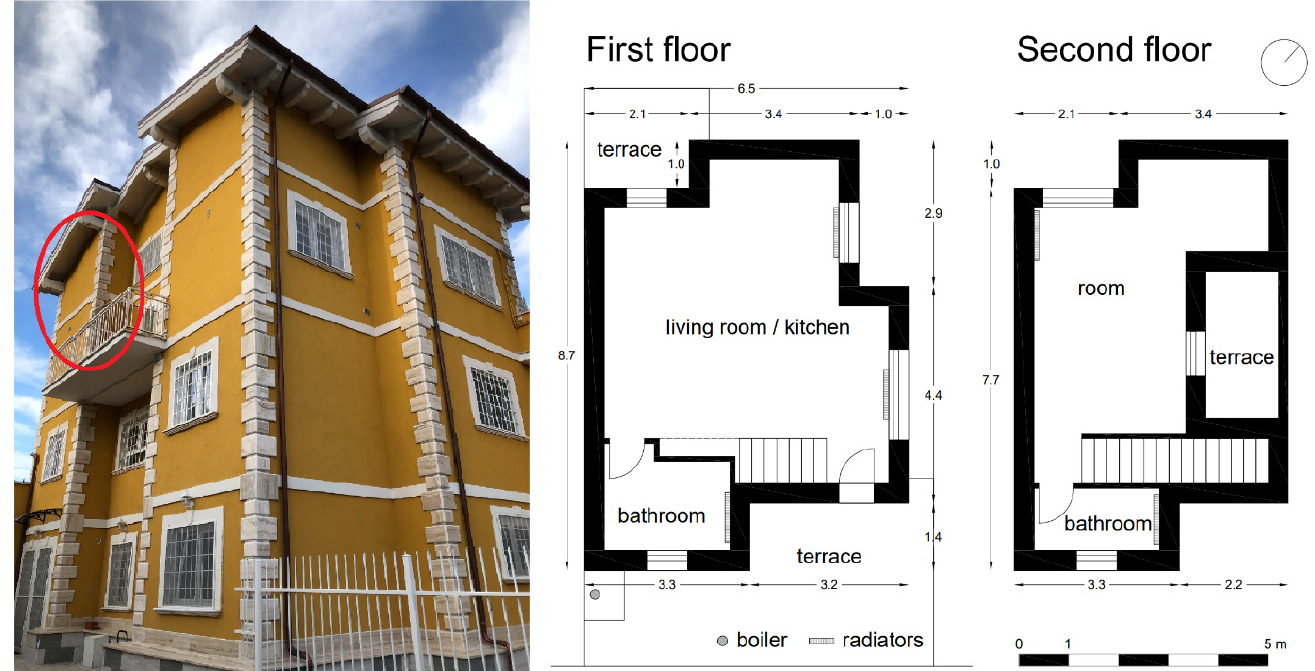
Figure 4. View and plans of the analysed case study. Table 1. Thermal and geometric characteristics of the opaque building